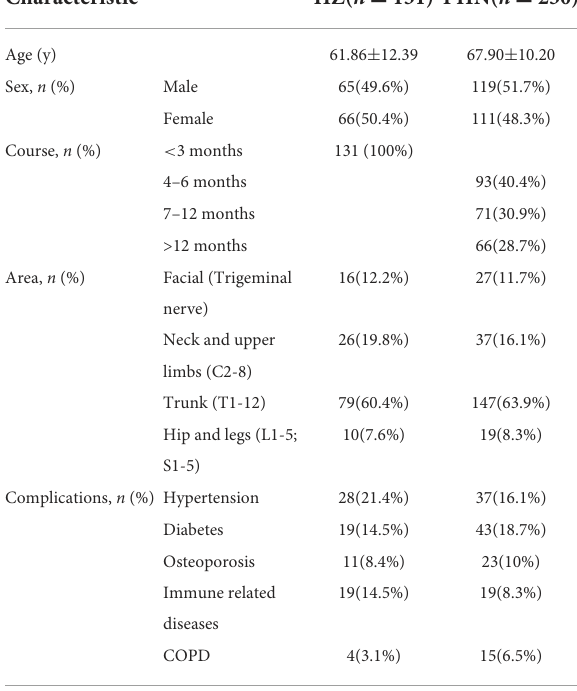
TABLE 1 The basic characteristics of